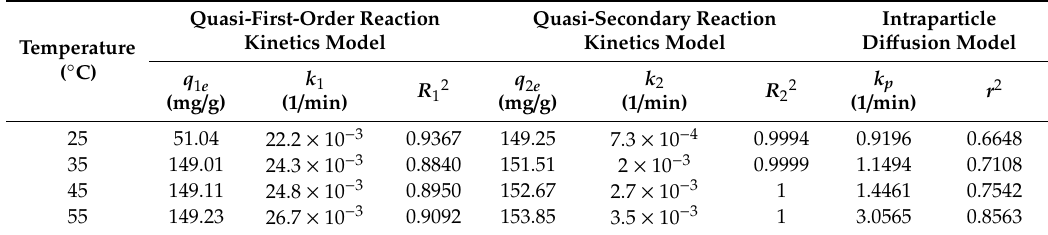
Table 6. E ff ect of temperature on the adsorption kinetics model. The adsorption test was conducted with a 300 mg / L MG solution and 2 g / L of modified sepiolite under an oscillation rate of 170 r / min.